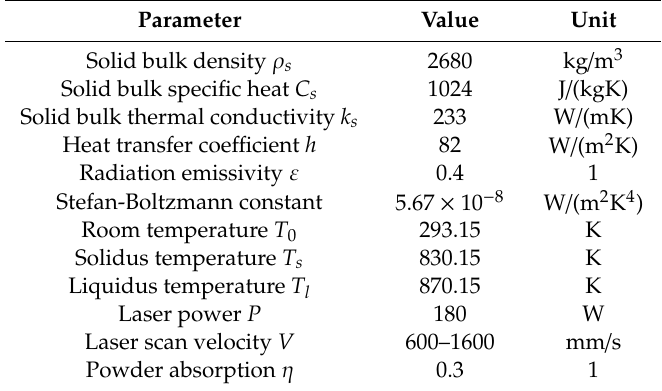
Table 3. Materials properties of AlSi10Mg and process parameters in PBMAM [43]. The laser scan velocities for test 1–4 are 600 mm / s, 800 mm / s, 1000 mm / s, and 1600 mm / s,